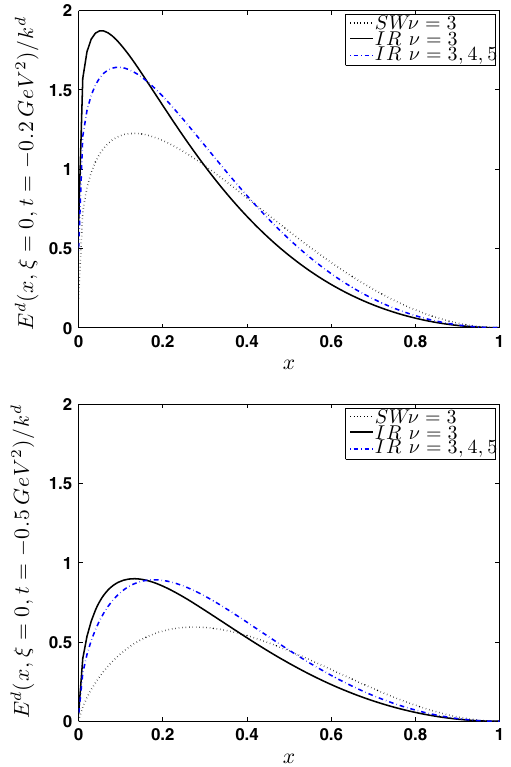
Fig. 8 Upper panel The results for E d ( x ,ξ = 0 , t = − 0 . 2GeV 2 ) ( x ,ξ = 0 , t = − 0 . 2GeV 2 ) Fig. 7 Upper panel The results for E u predictedbytheimproved-IRmodelandtwist-3contributiononly( con- V predictedbytheimproved-IRmodelandtwist-3contributiononly( con- tinuous line ) are compared with the results obtained including higher tinuous line , the same results of Fig. 6) are compared with the results Fock states ( dot-dashed ), namely ν = 3 , 4 , 5; cf. Sect. 3.2). The predic- obtainedincludinghigherFockstates( dot-dashed ),namely ν = 3 , 4 , 5; tions of the corresponding SW model are also shown ( dotted ). Lower cf. Sect. 3.2). Lower panel As in the upper panel for t = − 0 . 5GeV 2 panel As in the upper panel for t = − 0 . 5GeV 2